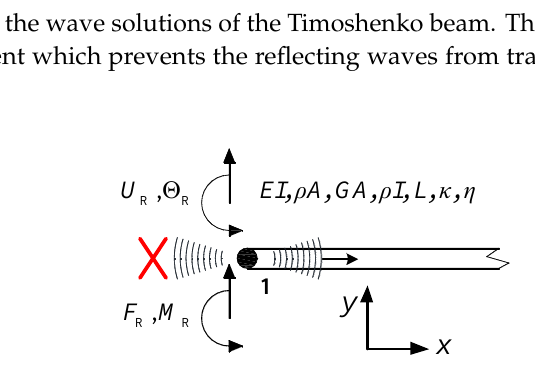
Figure 5. One-node Timoshenko beam right-throw-off element.